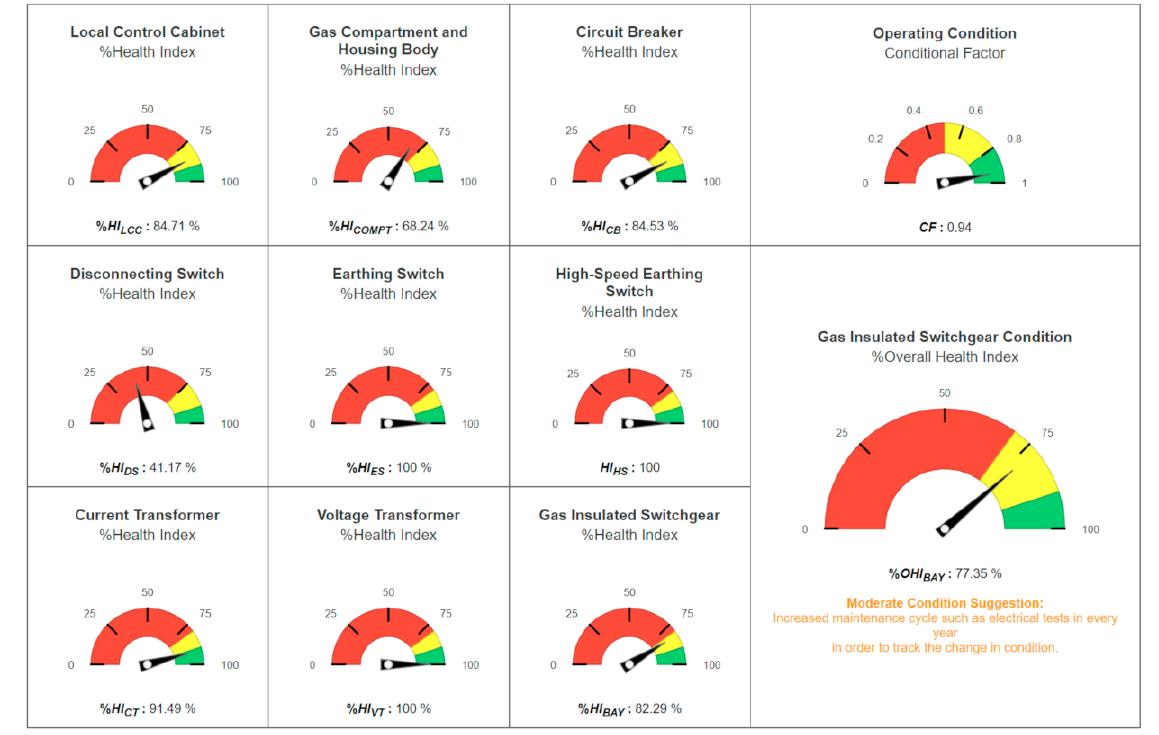
Figure 6. Bay-E02 web application result display for condition evaluation